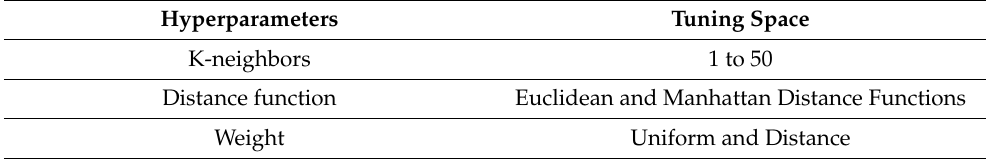
Table 5. Tuning Space for Hyperparameters in the kNN